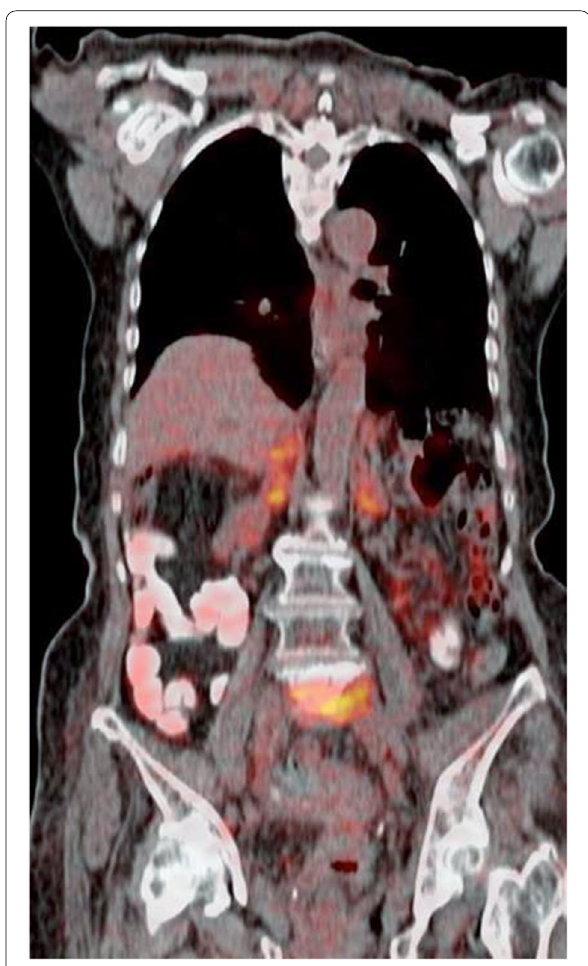
Fig. 2 Sixty-nine-year-old female patient with the diagnosis of metastatic colon carcinoma; the coronal fusion FDG PET/CT slices corresponding to multiple metastatic adrenal lesions with significant FDG accumulation with the greatest dimension of 23 mm (SUVmax 6.9 right/SUVmax 8.3 left-liver background = = SUVmax =